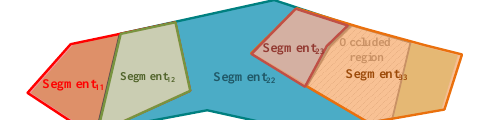
Figure 9. The intersection between visible sub-regions in each image